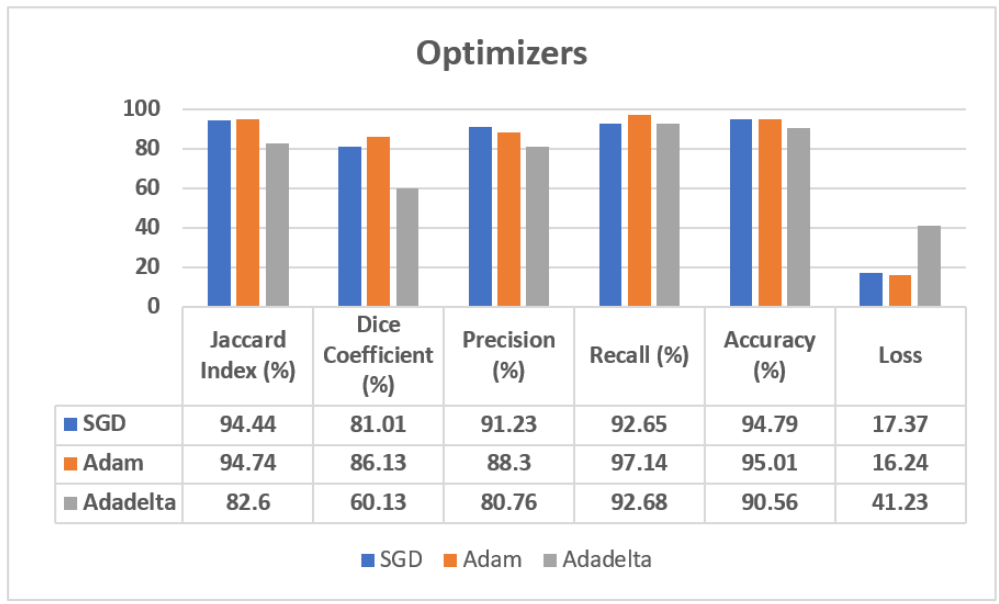
Figure 7. Analysis of confusion matrix parameters on different optimizers.